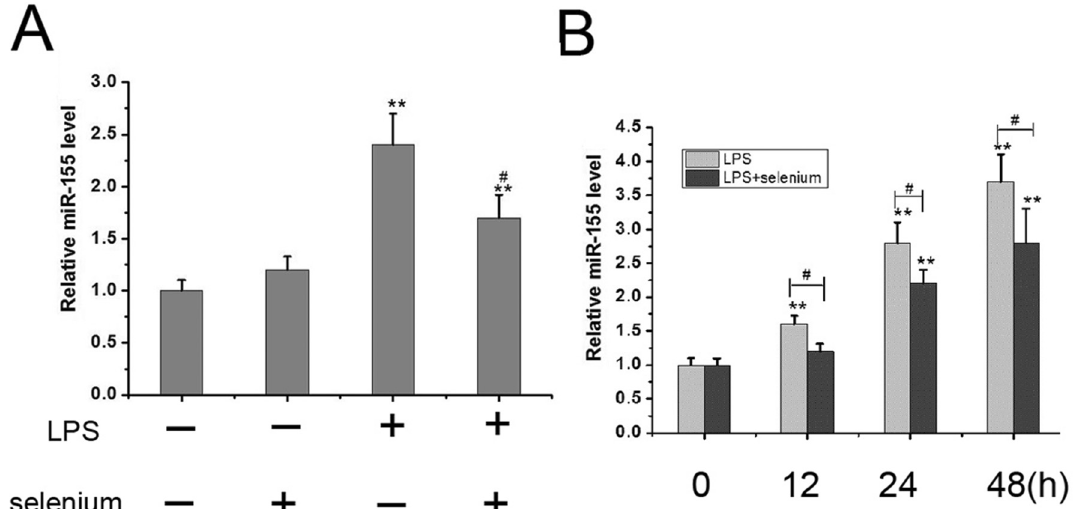
Figure4 -SeleniumdecreasedthelevelofmiR155inMC3T3-E1cells.(A)MC3T3-E1cellswereincubatedin100ng/mlLPSinthepresenceorabsence of 4 ng/ml sodium selenite for 24 h, and the level of miR-155 was detected by qRT-PCR. The data were mean (cid:6) SEM (n=6). (** P < 0.01, vs.control;# P < 0.05, LPS vs. LPS+selenium group) . (B) MC3T3-E1 cells were treated with 200 ng/ml LPS in the presence or absence of 4 ng/ml sodium selenite for 0, 12, 24 and 48h,and the level of miR-155 was detected by qRT-PCR. The data were mean (cid:6) SEM (n=6). (** P < 0.01, vs.0 hour group;# P < 0.05, LPS vs. LPS+selenium